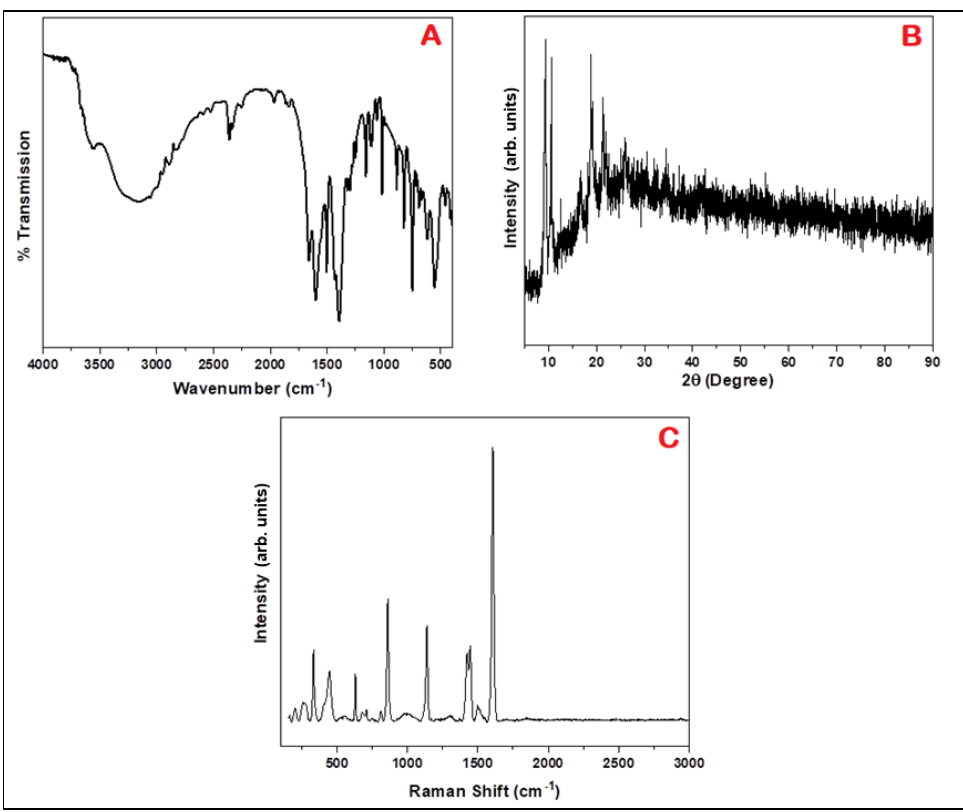
Figure 5. Characterisation of MIL-101(Fe): ( A ) FT-IR spectra of MIL-101(Fe), ( B ) XRD pattern of MIL-101(Fe) and ( C ) Raman spectra of MIL-101(Fe).